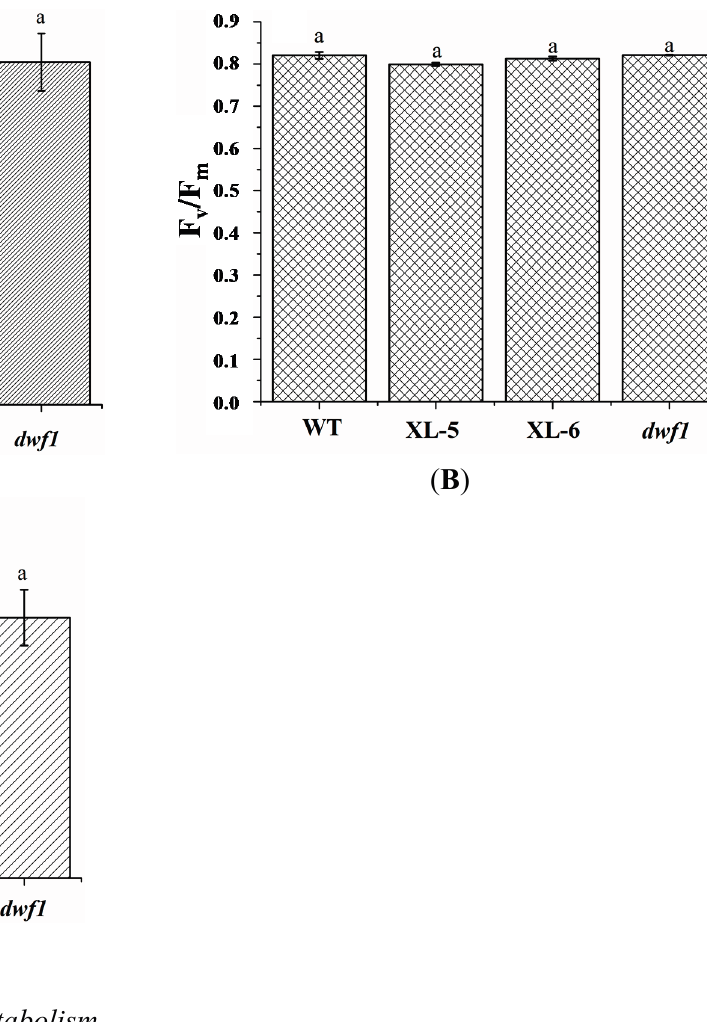
Figure 4. Photosynthetic fluorescence parameters chlorophyll fluorescence parameters (F 0 and F v /F m ) and photosynthetic efficiency of XL-5, XL-6, dwf1 , and WT. Results are presented as the mean ± SD of three independent experiments. ( A ) F 0 ; ( B ) F v /F m